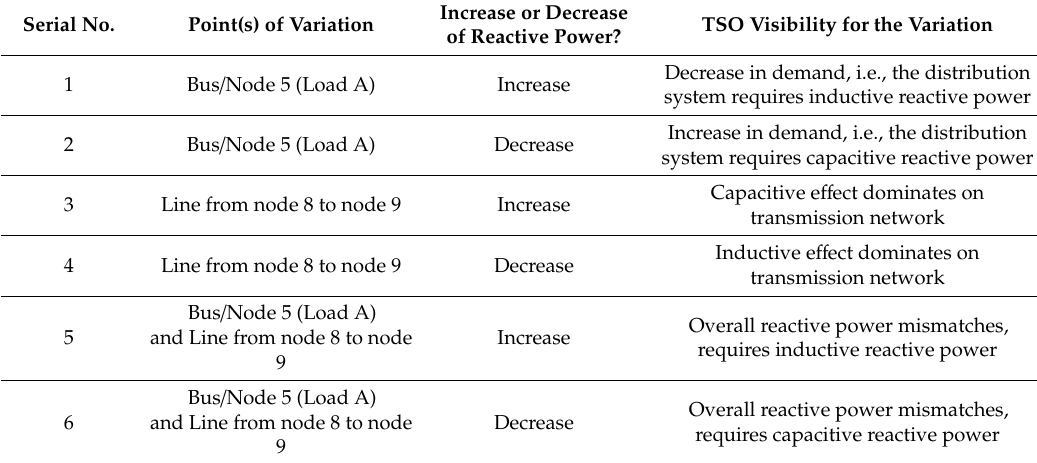
Table 2. Look-up table for TSO